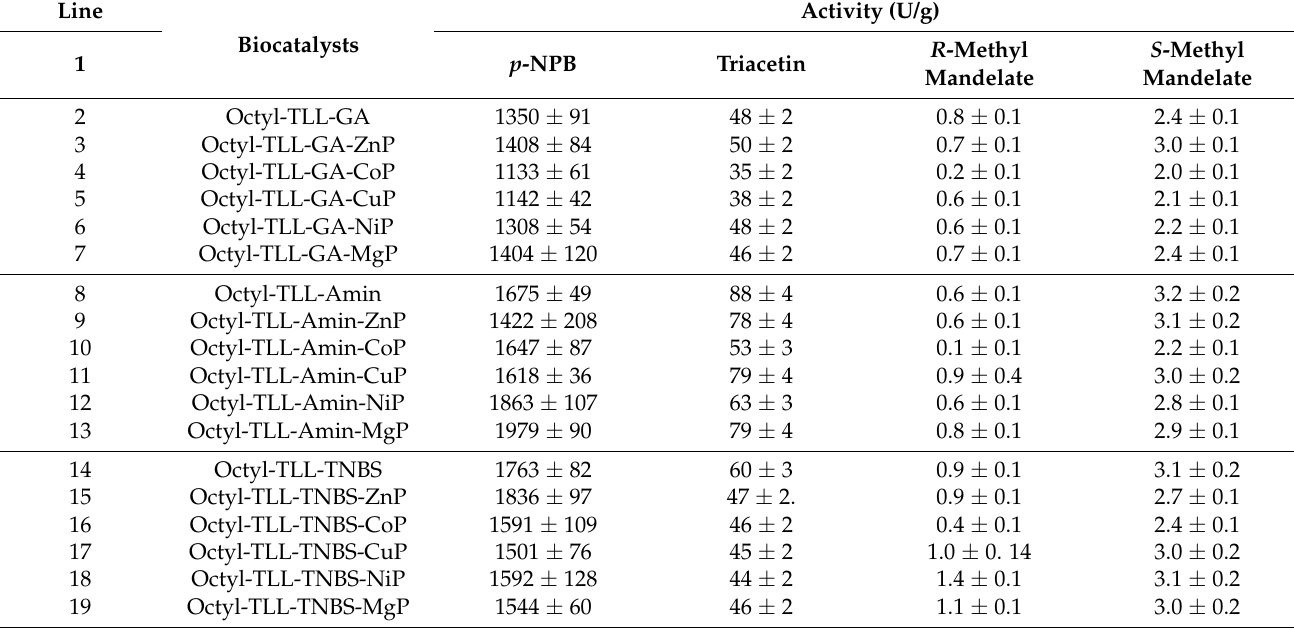
Table 3. Specific activity of different immobilized and chemically modified TLL biocatalysts after mineralization. The hydrolytic activity was measured using 1 mM p -NPB (pH 7 and 25 ◦ C), 50 mM triacetin (pH 7 and 25 ◦ C), and 50 mM R - or S -methyl mandelate (pH 7 and 25 ◦ C). Experiments were conducted as described in